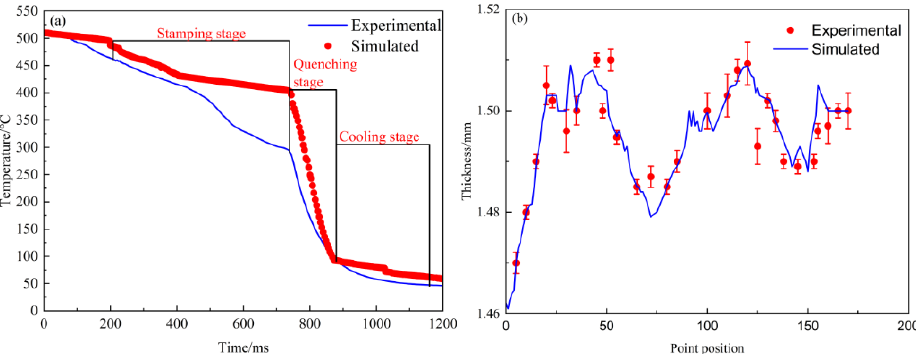
Figure 8. Comparison of experimental and simulated data: ( a ) Temperature variation, ( b ) Thickness distribution.